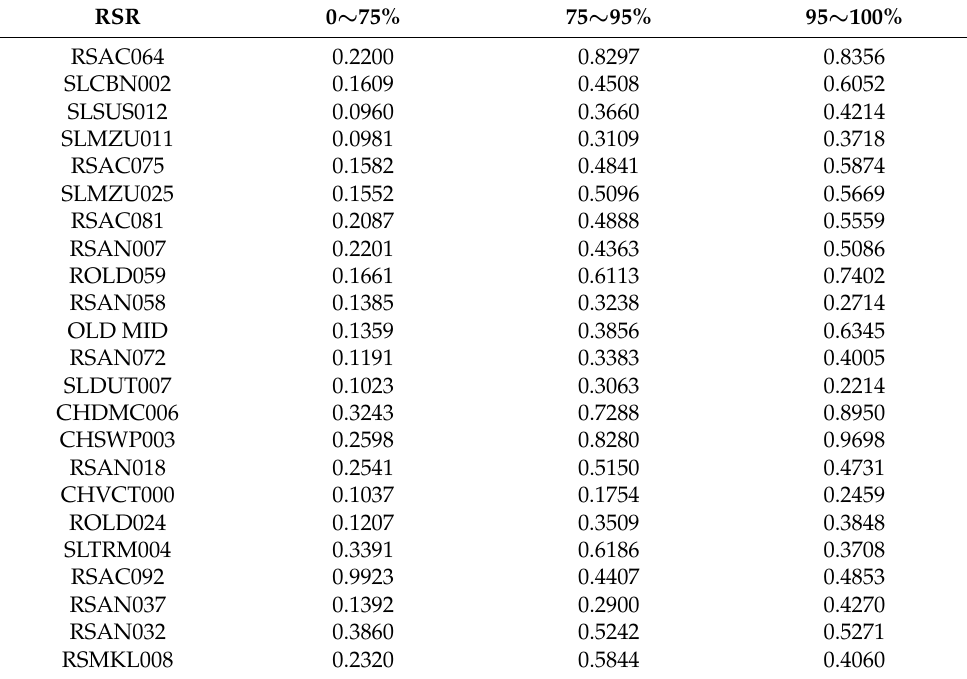
Table A4. Station-wise RSR results of Res-LSTM at hourly time step with daily